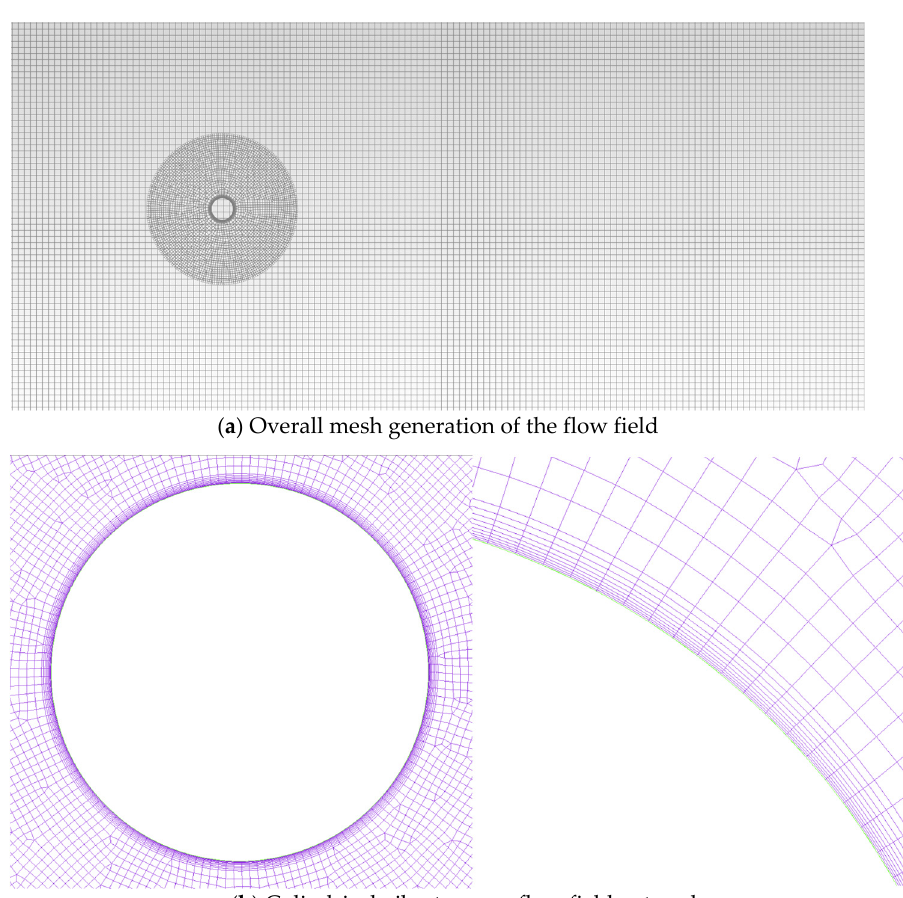
Figure 4. Flow field mesh generation. Table 2. Grid-Irrelevance Verification Results.